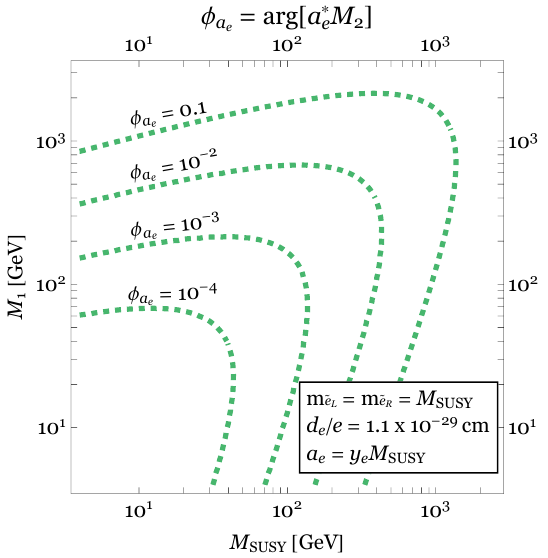
Figure 3 . The ACME II constraint on the selectron mass scale M The left region of each contour is excluded. We plot four cases of the phase (cid:30) 0 : 1 ; 10 (cid:0) 2 ; 10 (cid:0) 3 ; 10 (cid:0) 4 . We assume the left-handed and right-handed selectron soft masses are the same, m ~ e = m ~ e = M SUSY L R